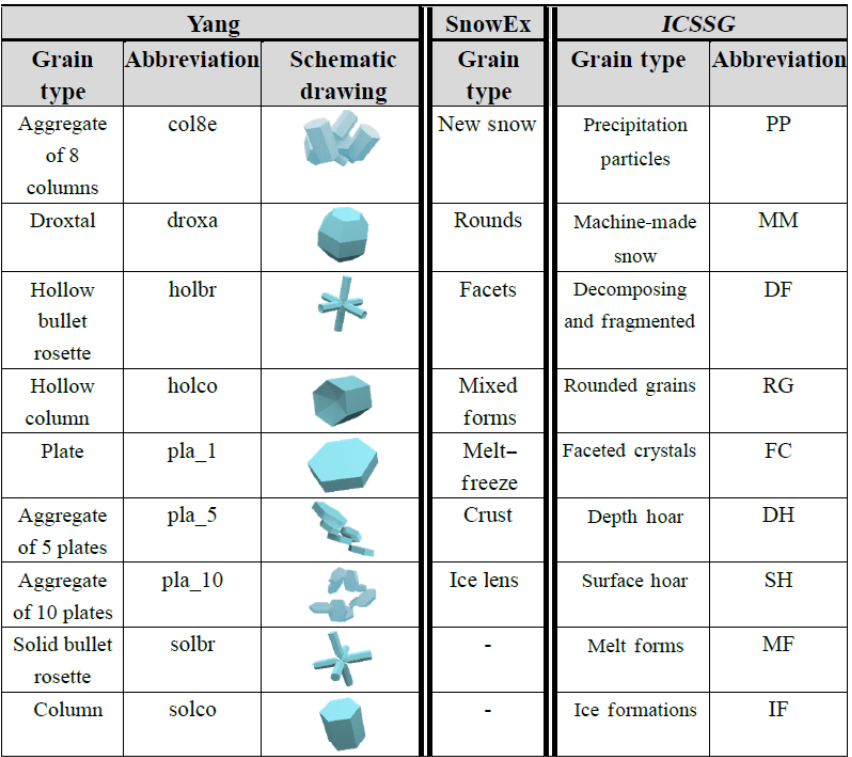
Table 2. Snow grain type (shape) provided by Yang et al. (2013), in situ measurements in the SnowEx campaign and by ICSSG . Please